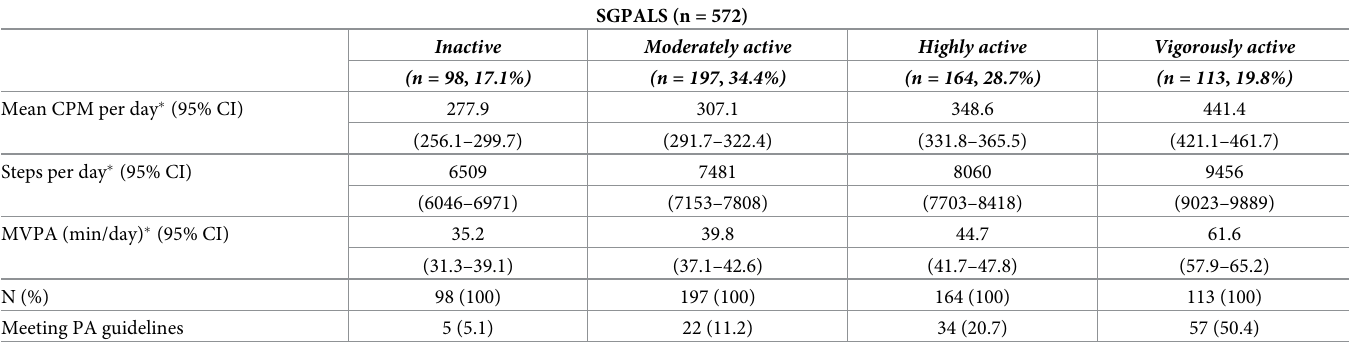
Table 3. Accelerometer measured physical activity according to the Saltin-Grimby Physical Activity Level Scale (SGPALS). The Fit Futures Study